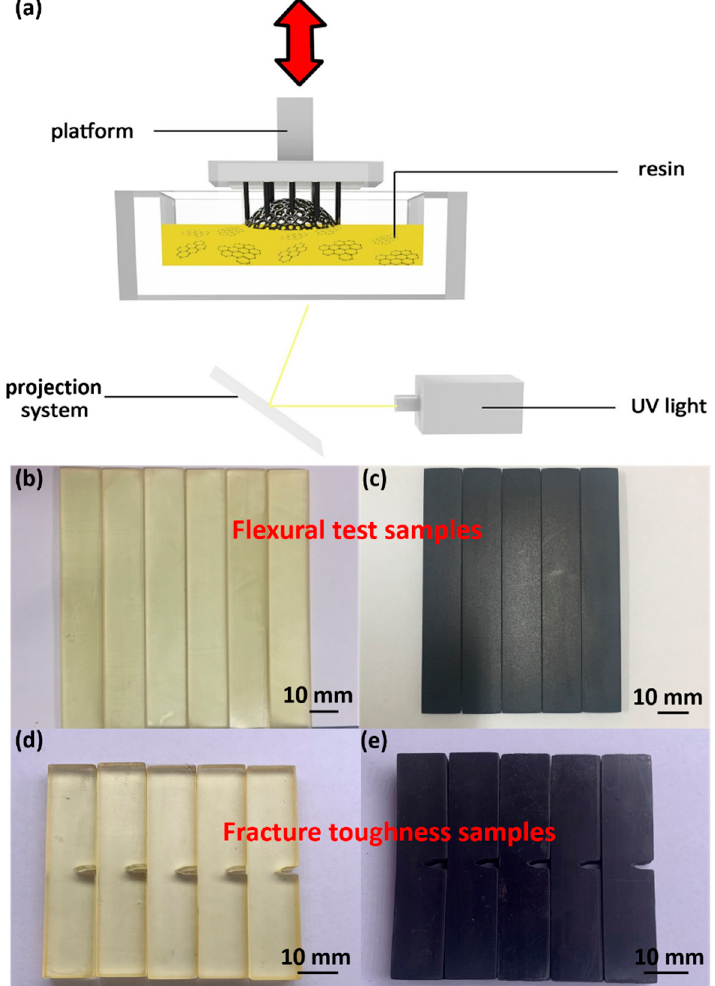
Figure 2. ( a ) Schematic of the digital light processing (DLP) process. Photographs of flexural test specimen ( b ) references without graphene and ( c ) with 0.5 wt.% graphene. Photographs of fracture toughness test specimens ( d ) without graphene and ( e ) with 0.5 wt.% graphene.